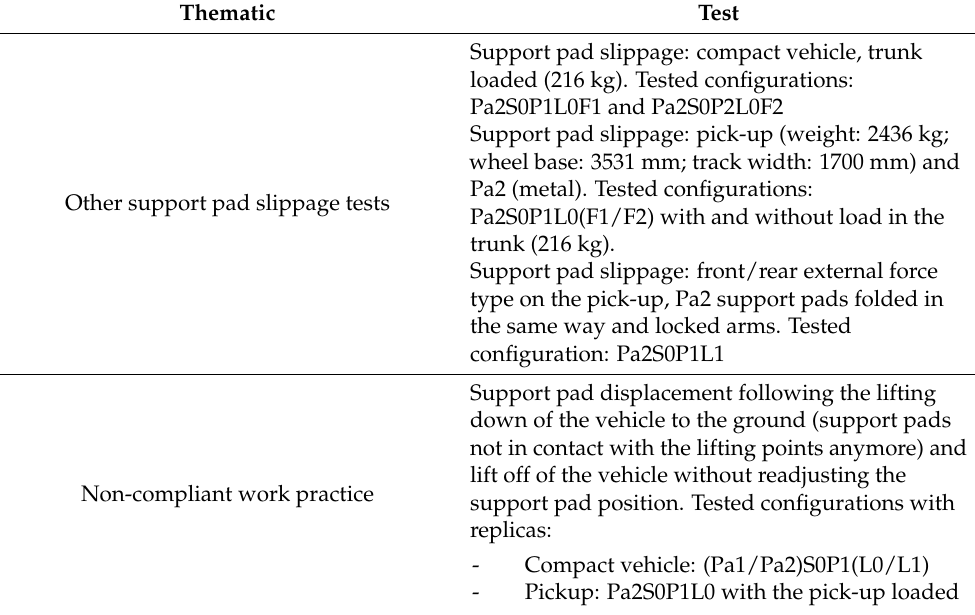
Table 4. Description of additional testing.